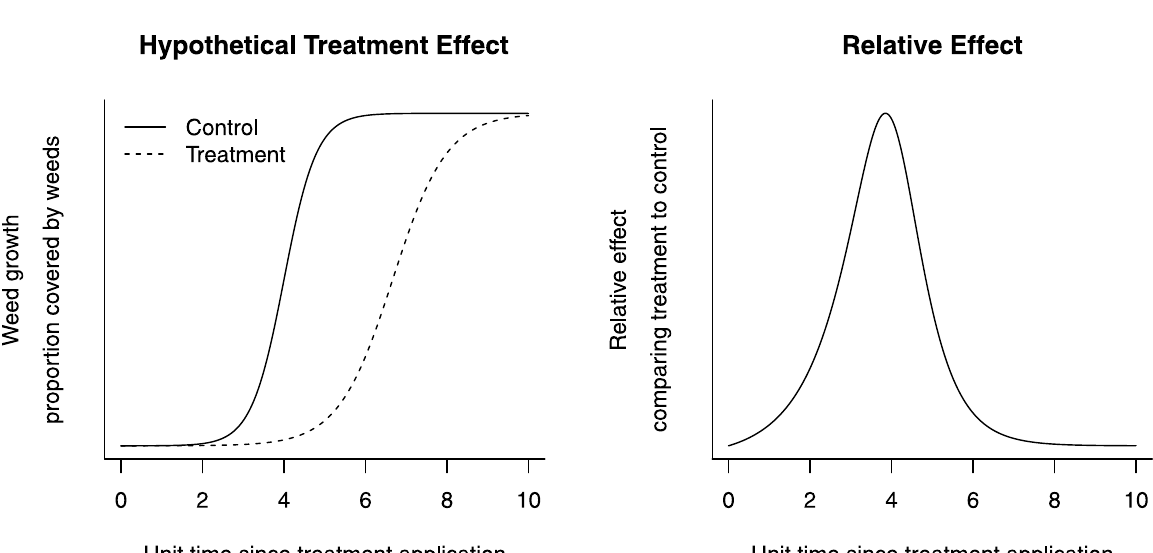
Fig 2. Treatment effect with respect to time since treatment application. This hypothetical scenario compares the weed density (proportion of area covered by weeds) between the treatment group and the control group with respect to time since treatment application. The quantification of treatment effect (relative to control) may be highly sensitive to the time of data